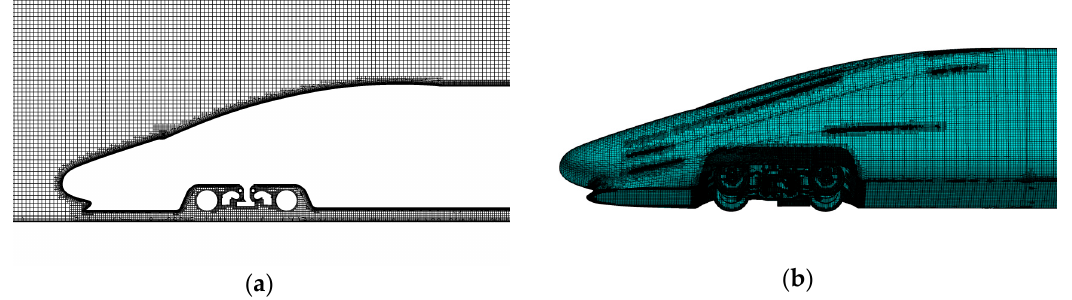
Figure 8. The grids on the longitudinal section and on the surface of leading streamline: ( a ) mesh distribution on the longitudinal section; and ( b ) surface grids of the leading streamline.